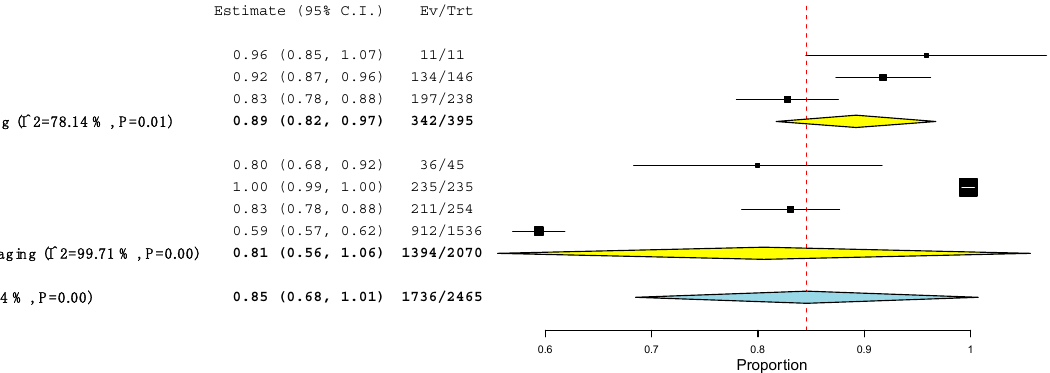
Figure 4. Sensitivity of 18 F-FDG PET/CT at the level of the lesions across studies.